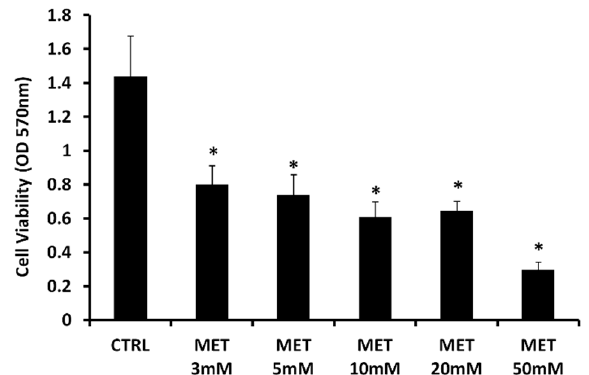
Figure 1. Metformin (MET) caused a decrease in cell viability. Cell viability, determined using MTT assay, of androgen-independent human prostate cancer cells (DU145), control untreated (CTRL) and treated with Metformin at different concentrations (3, 5, 10, 20, and 50 mM) for 24 h. Data are the means ± SD of three experiments performed in triplicate * p < 0.05 versus DU145 untreated cells.